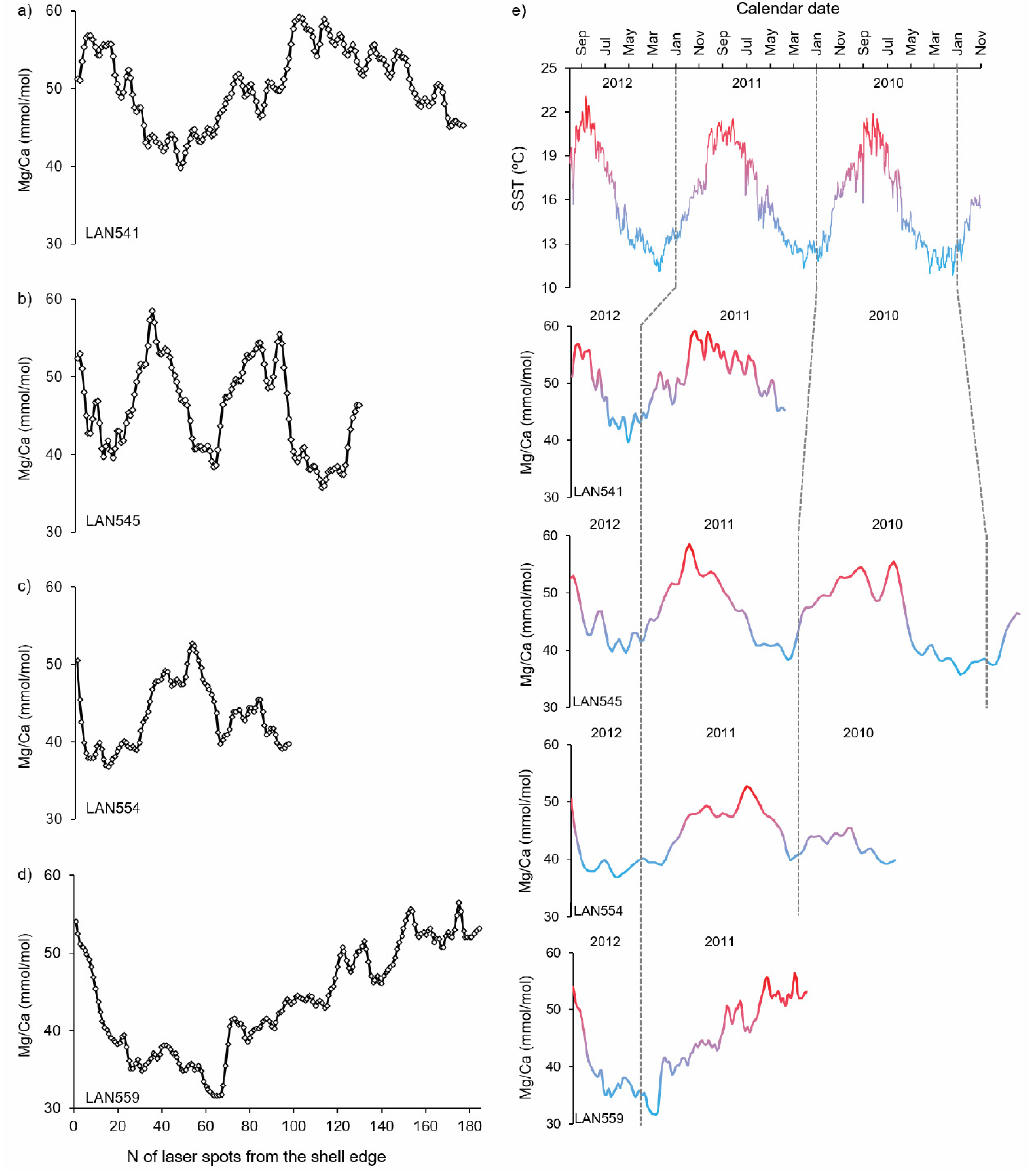
Figure 6. Mg/Ca ratio sequences obtained from ( a ) LAN541, ( b ) LAN545, ( c ) LAN554, and ( d ) LAN559. ( e ) Comparison between Mg/Ca ratio sequences and instrumental SST ( T meas ). Red and blue colors indicate warm (i.e., summer) and cold (i.e., winter) temperatures, respectively.